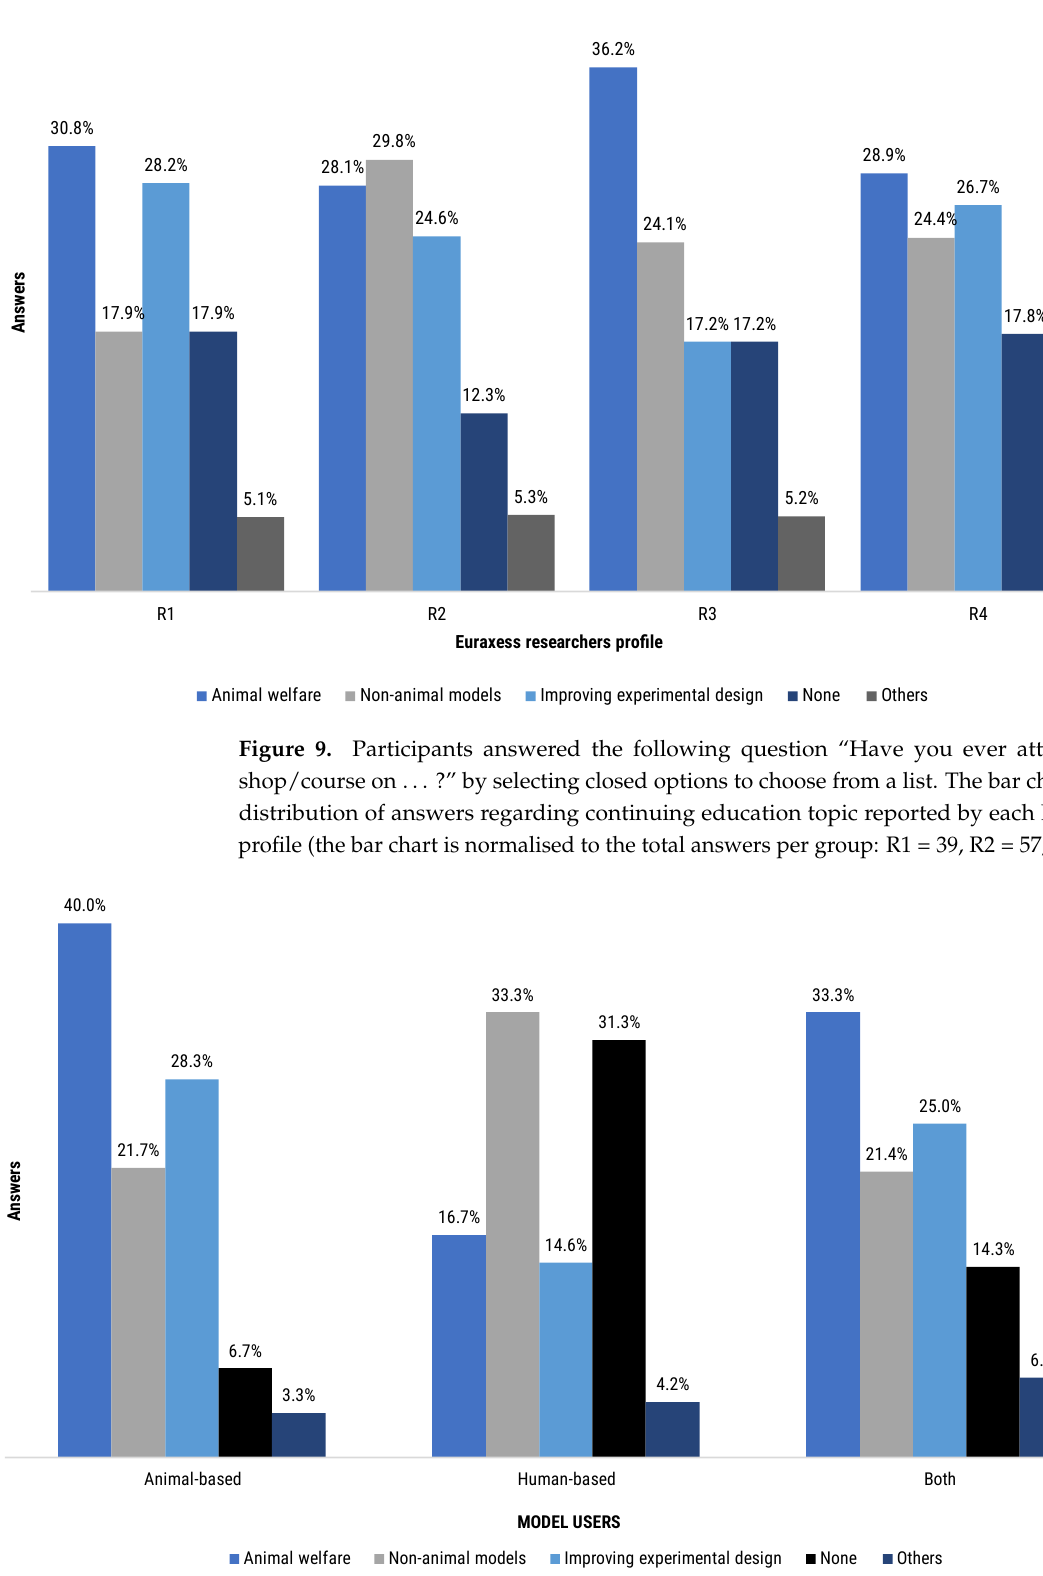
Figure 10. Participants answered the following question “Have you ever attended any work- shop/course on . . . ?” by selecting closed options to choose from a list. The bar chart represents the distribution of answers regarding continuing education topic reported by type of mode users (the bar chart is normalised to the total answers per group of model users: animal-based models = 60, human-based models = 48, both models = 84).